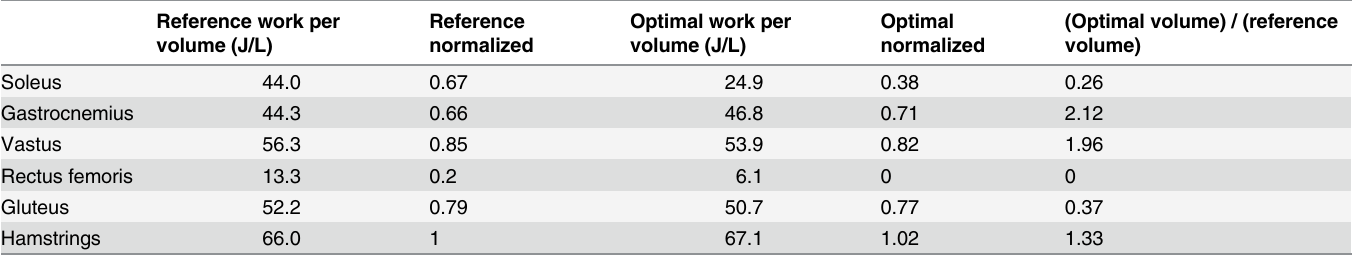
Table 2. Individual muscle work per volume for the reference and optimized models. The first column is the work/volume for each muscle in the refer- ence model (and the second column presents these data normalized by the most efficient muscle, hamstrings). The third column shows the work/volume ratio in the optimal model. The fourth column again presents this volume-specific work of the optimal model normalized by that of the hamstrings. The fifth col- umn shows the percentage by which each muscle is scaled in the optimal model, relative to the reference model (values larger than 1 therefore indicate an